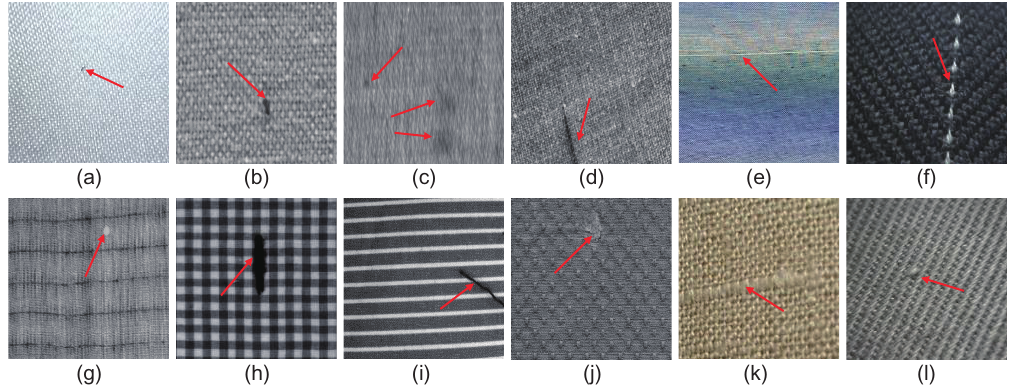
Figure 2. Defective fabric samples with different patterned textures.